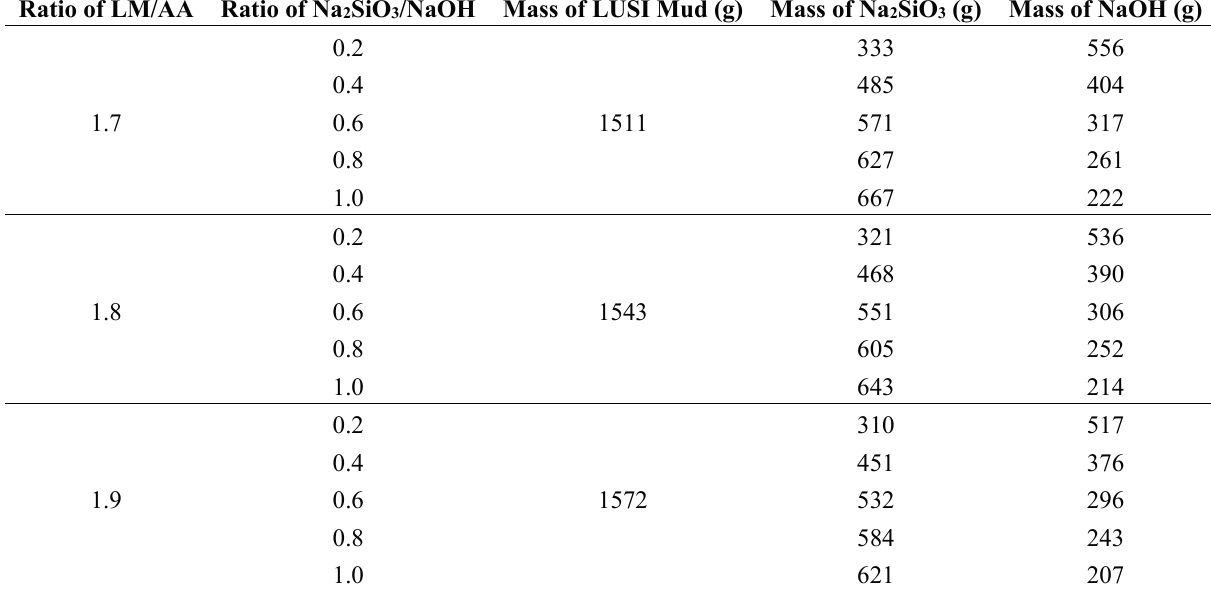
Table 3. Details of mix design for various ratios of LUSI mud/alkaline activator (LM/AA) and Na 2 SiO 3